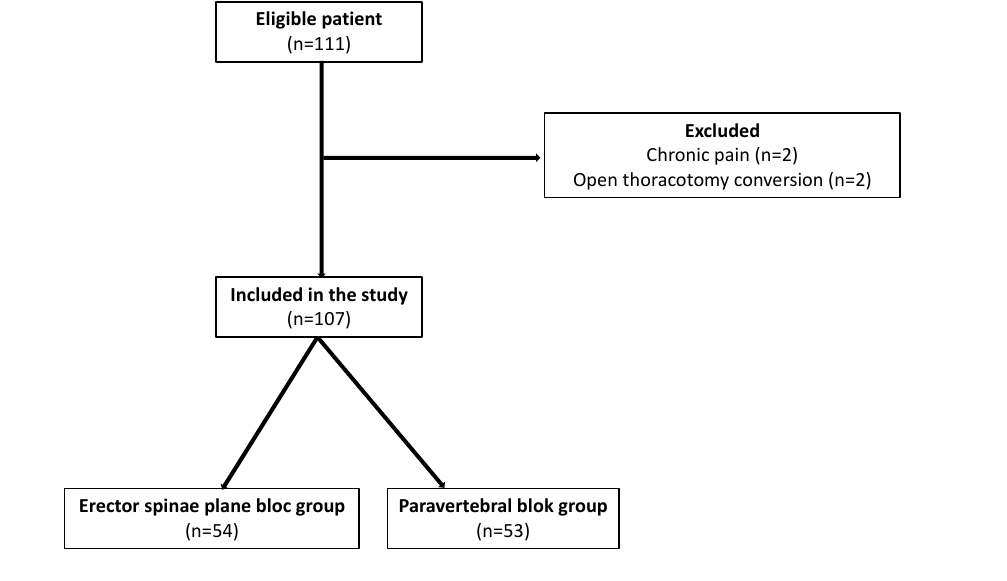
Figure 1. Flowchart of the study. Table 1. Post-operative pain at rest and cough at 24 h.